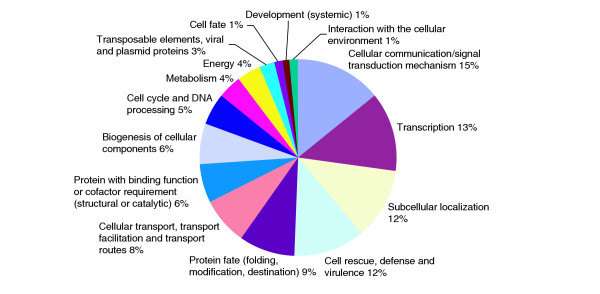
Functional distribution of the 65 most plastic genes. The 65 most plastic genes identified from the expression correlation analysis, whose correlation coefficients are less than 0.5 in all 10 pairwise compared accessions, were subjected to MIPs functional classification based on their annotations.